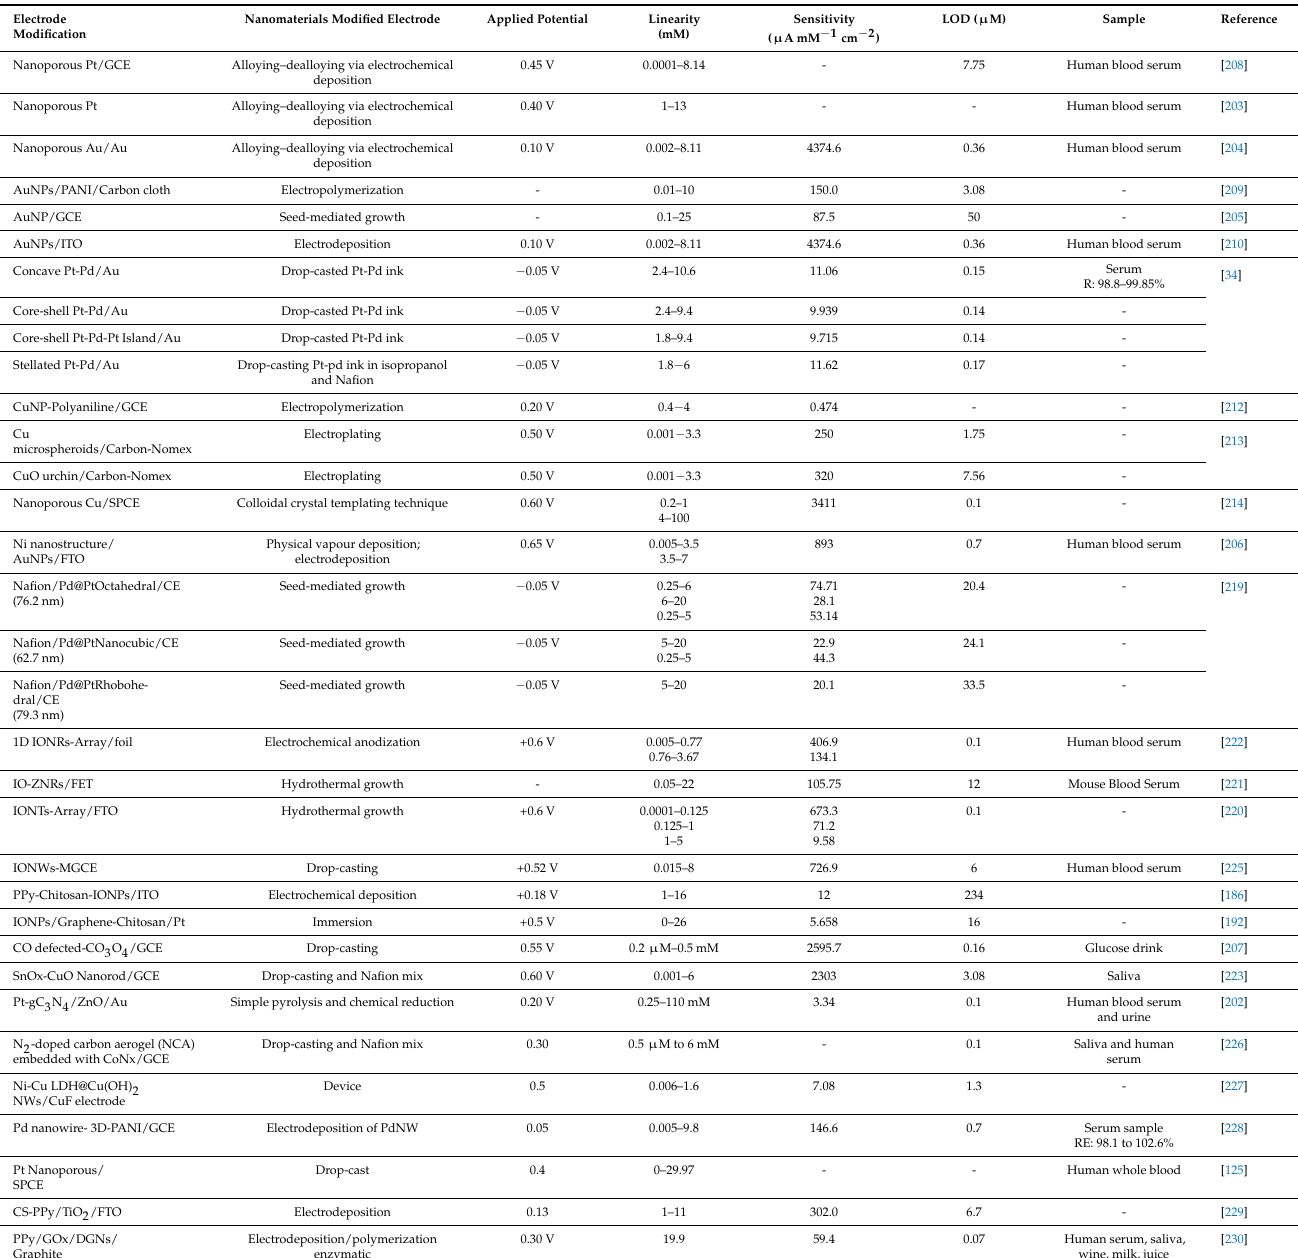
Table 7. Summary of the non-enzymatic glucose biosensors based on metal-based nanomaterials, metal oxide-based nanomaterials and